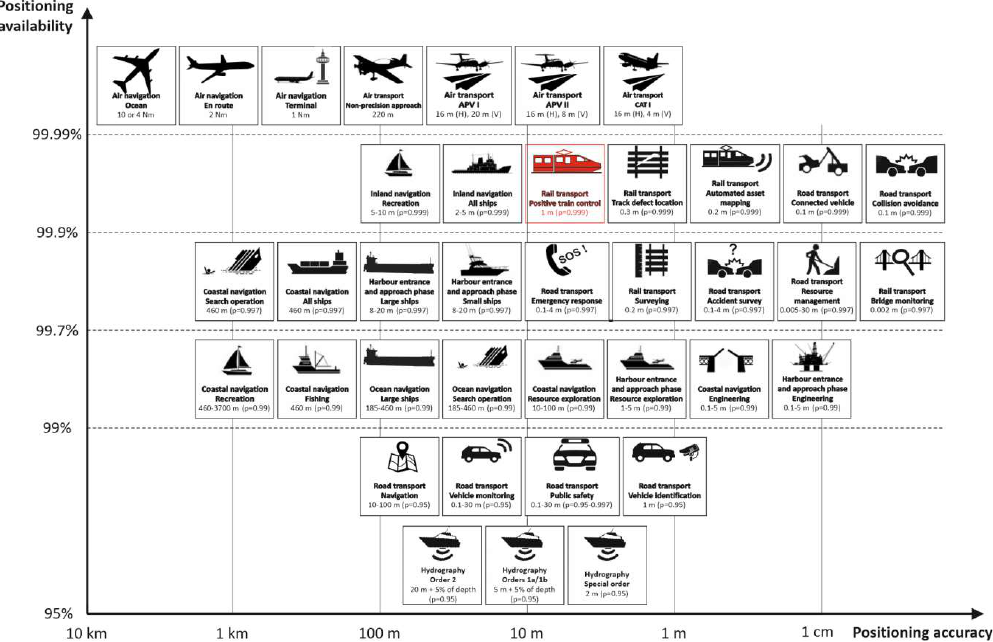
Figure 3. Requirements for positioning system accuracy and availability in rail transport compared to other navigation types. Own study based on: [37,57–59,61,62].